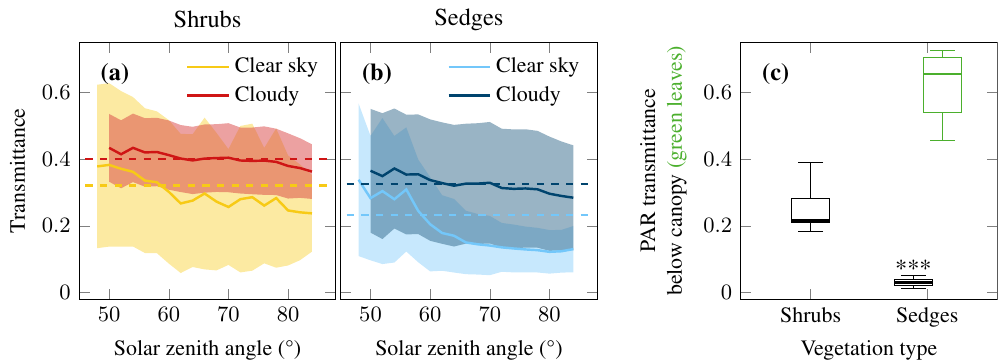
Figure 8. (a, b) Shortwave transmittance depending on solar zenith angle and cloud cover for dwarf shrub (a) and wet sedge (b) , growing season mean ± standard deviation calculated for 2 ◦ intervals, the dashed lines represent the mean diel value under each condition and (c) spatial variability of PAR (400–700nm) transmittance measured 3 August 2013, percentiles (25, 50, and 75), minimum and maximum values of eight plots per vegetation type; significant differences between vegetation types are shown with ∗∗∗ ( p ≤ 0.001).